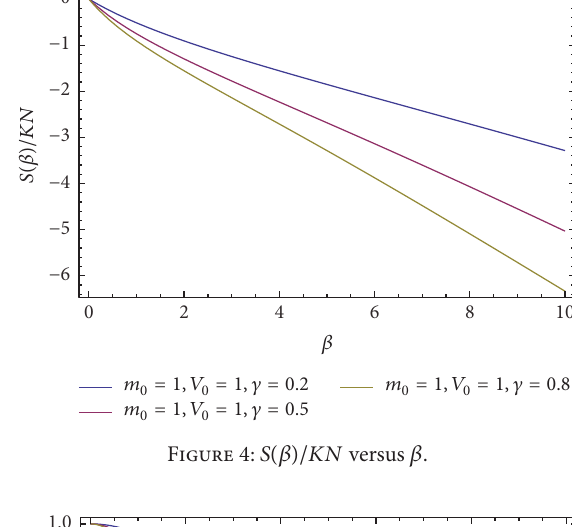
Figure 4: 𝑆(𝛽)/𝐾𝑁 versus 𝛽 .